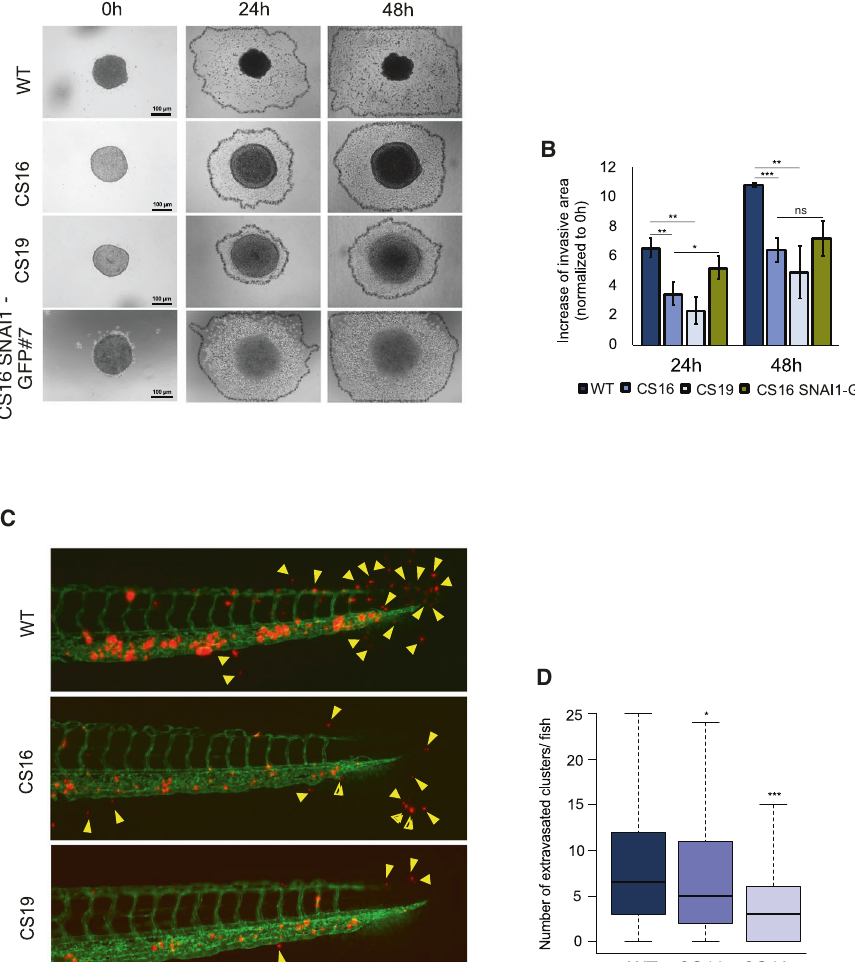
Fig. 4 SNAI1 knockout reduces cell invasion. A , B Representative phase-contrast images from three biological repeats of MDA-MB-231-WT, SNAI1 -KOs, ZR-75-1 and CS16 SNAI1-GFP#7 mammospheres embedded in collagen. Black lines demarcate the outer rim formed by invasive cells after 24 or 48 h ( A ) with quanti fi cation of the invasion area subtracted by the mammosphere area ( B ). Data are presented as mean values ± SEM of three biological replicates, each in technical triplicates and p -values are shown based on two-tailed unpaired Student ’ s t -test. C , D Representative images of zebra fi sh 24 h post-implantation with GFP-positive vasculature and CM-Dil dye-positive red cells. Extravasated cell clusters are indicated with yellow arrows ( C ). Quanti fi cation of extravasated cell clusters and associated signi fi cance ( D ). Data values from 150 WT, 142 CS16 and 152 CS19 zebra fi sh per cell line are presented as mean values ± SEM and p -values are shown based on two-sided Wilcoxon sum-rank U test. p -values * p ≤ 0.05, ** p ≤ 0.01, *** p ≤